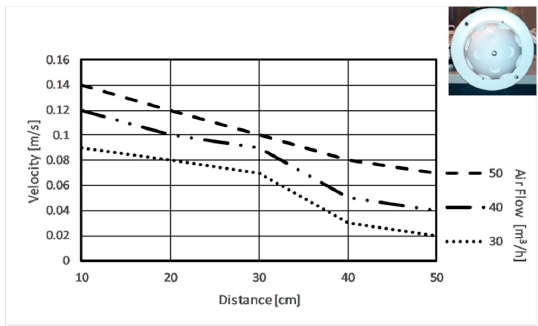
Figure 8. Mean air velocities in the case of closed ZMD type ATD.